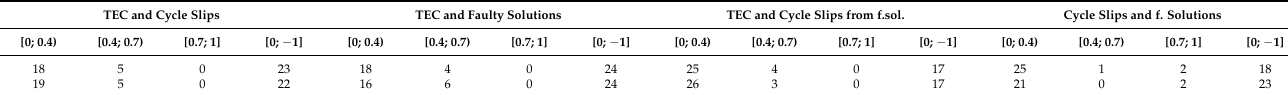
Table 8. Count of Pearson’s correlation coefficients before the removal of the Loss-of-Lock (1st row) and after the removal of the Loss-of-Lock (2nd row).